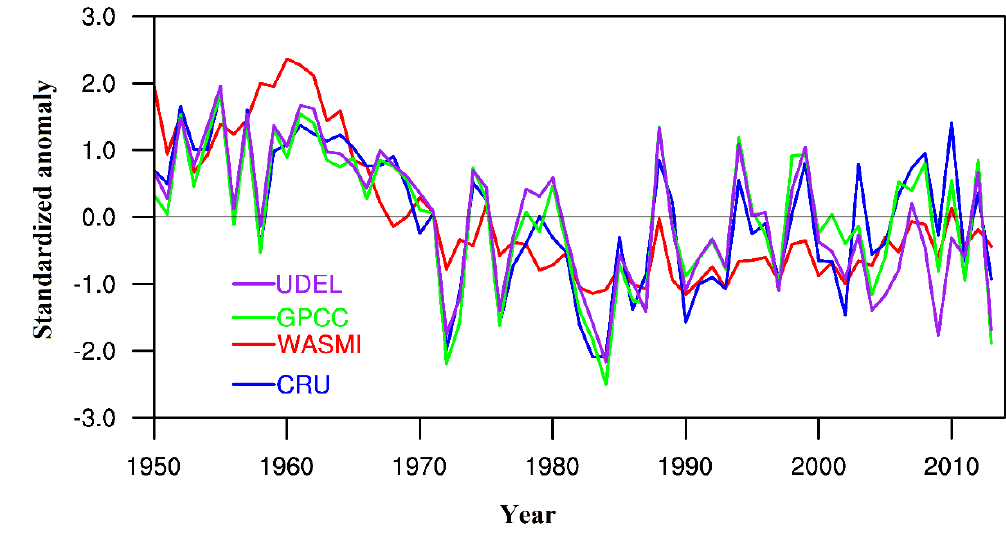
Figure 8. Time series of the standardized anomaly of the WASMI and the three gridded rainfall observations. Table 1. Correlation coefficient values between various indices and rainfall datasets.